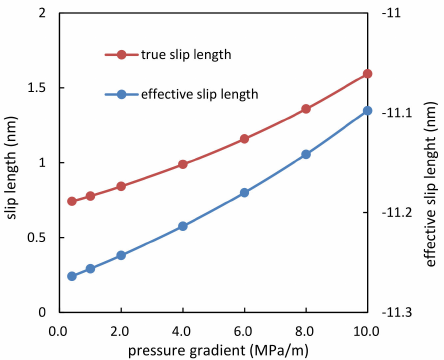
Figure 12. Comparison of slip lengths.